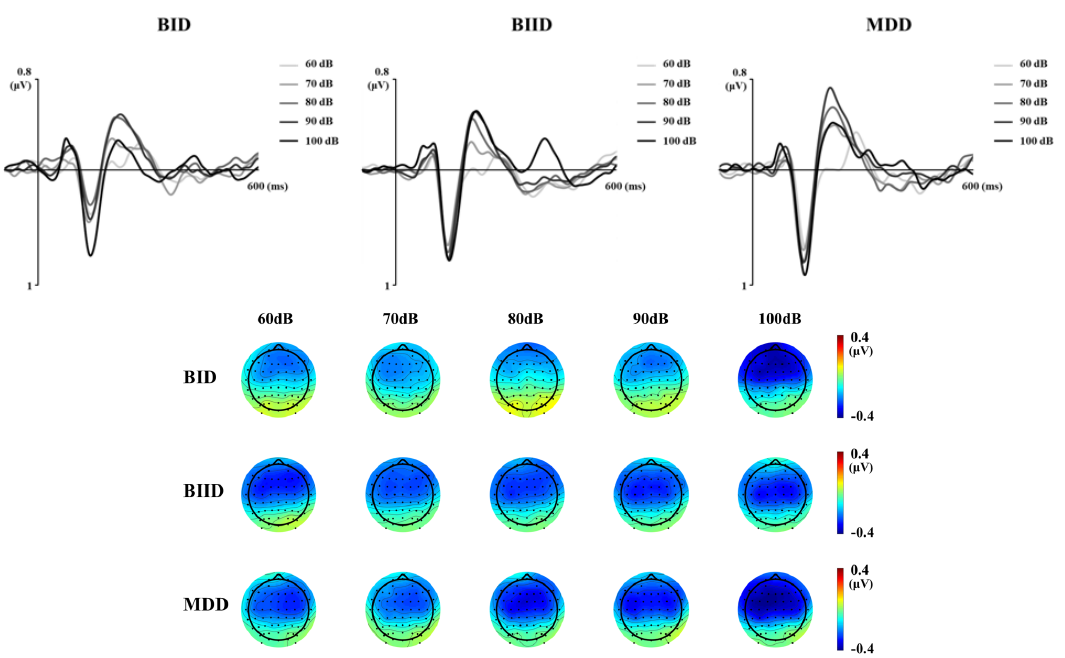
Figure 4. Mismatch negativity (MMN) waveforms and topographic MMN maps in the Fz electrode in the MDD (major depressive disorder), BIID (bipolar II disorder), and BID (bipolar I disorder) groups (Time frame ranges from 130 to 250 milliseconds).